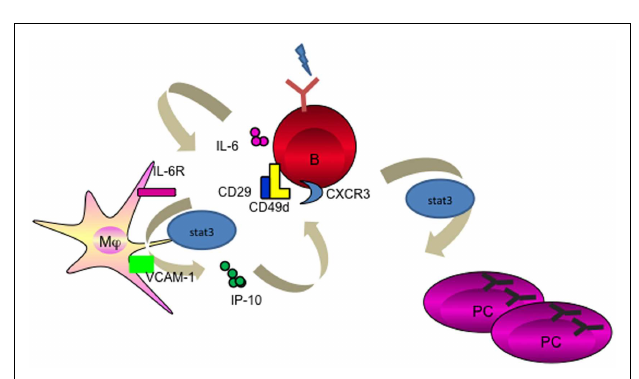
FIGURE 2 | Macrophage mediates PC differentiation . Activated B cells release IL-6 to activate macrophage through STAT3. Macrophage-derived IP-10 sequentially binds to CXCR3 on B cells to trigger amplification loop production of IL-6, leading to STAT3-dependent PC